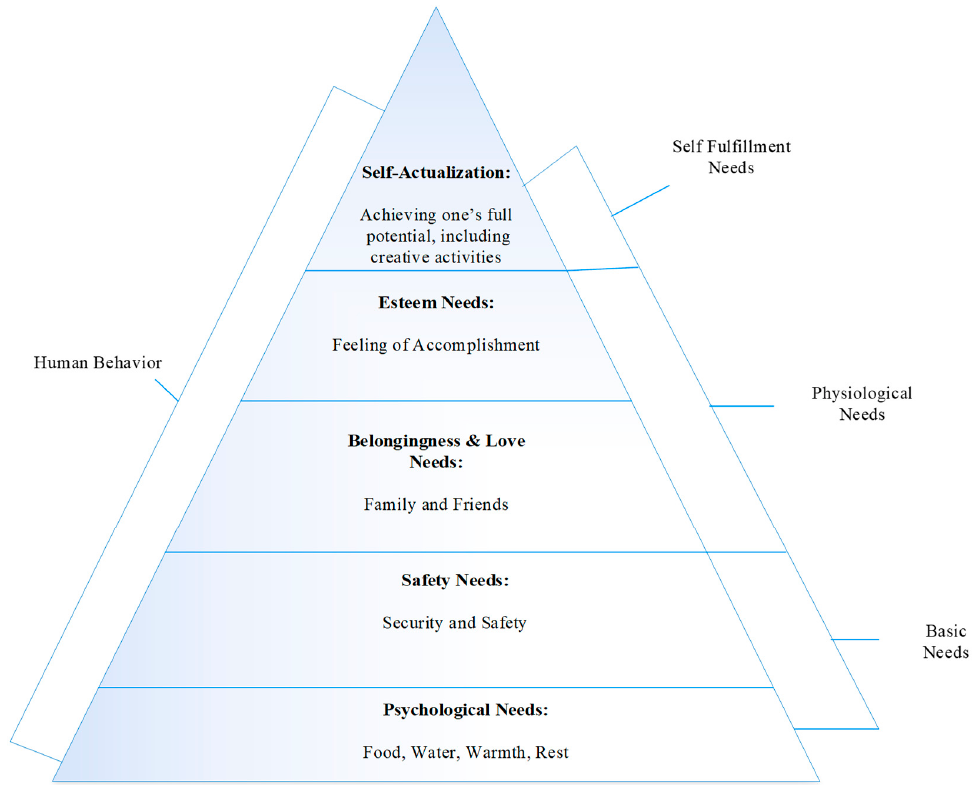
Figure 1. Maslow’s hierarchy [1].